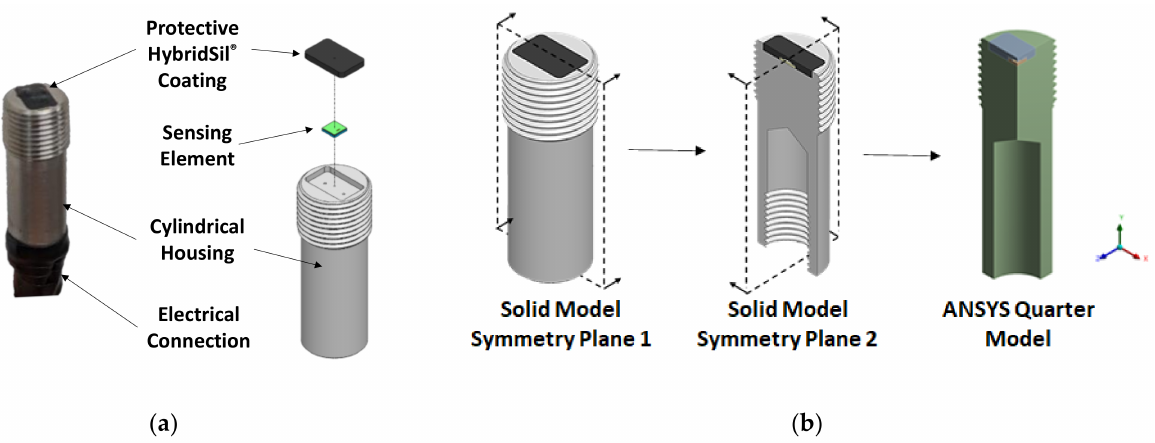
Figure 1. ( a ) Picture ( left ) and CAD model ( right ) of the self-calibrating pressure sensor showing the four main components and ( b ) geometry of the self-calibrating pressure sensor as implemented in